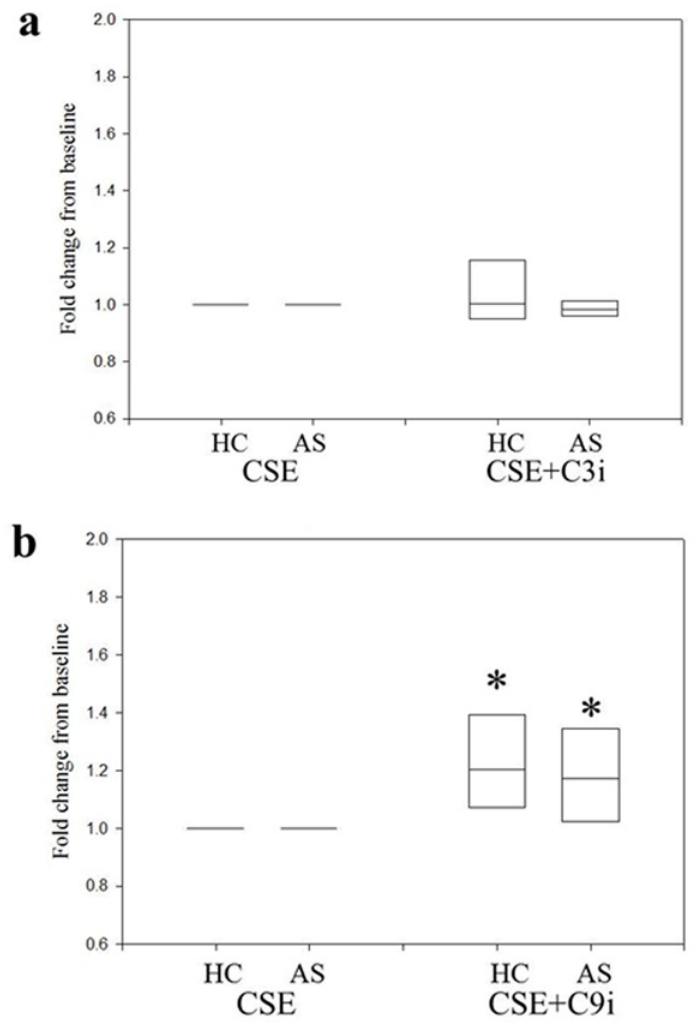
Fig 5. Effect of Caspase Inhibitors on CSE-Induced Apoptosis. PBEC obtained from 4 non-asthmatic and 4 asthmatic donors were treated for 24h with 20%CSE alone or in combination with Ac-DEVD-CHO (C3i) (a) or Z-LEHD-FMK (C9i) (b). Changes in EA were evaluated with AxV staining. The results are displayed as a box plot showing median and 5 – 95% confidence intervals of fold changes from CSE only in both